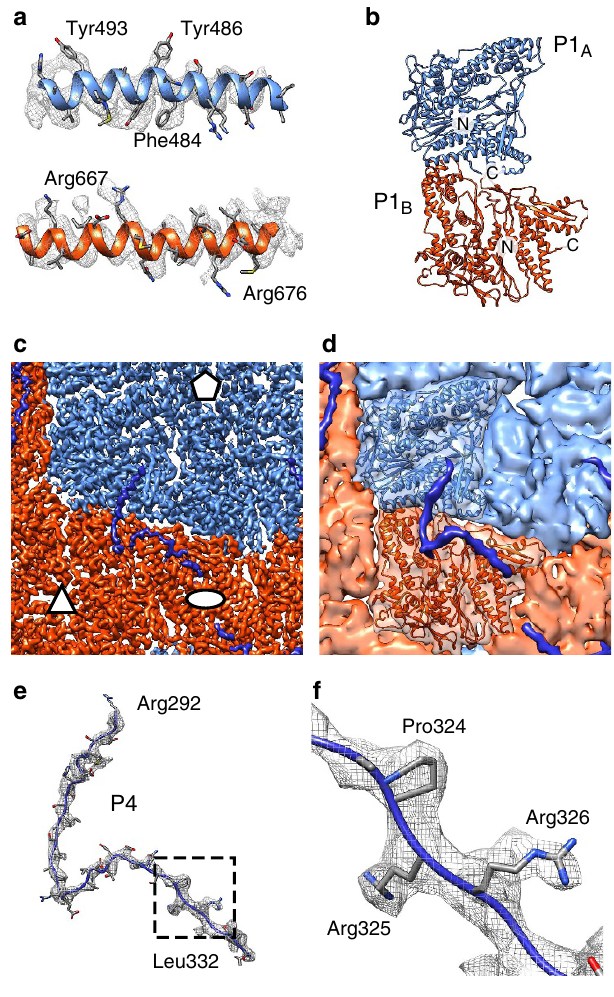
Figure 4 | Structure of the inner P1 shell. ( a ) Close-ups of the atomic models for the f 6 P1 A (top) and P1 B (bottom) subunits and corresponding density (mesh). ( b ) Atomic model of the asymmetric P1 dimer. The two subunits and the N- and C-termini are labelled. ( c ) Close-up of the density map. Icosahedral symmetry axes are labelled with an ellipse (two-fold), a triangle (three-fold) and a pentagon (five-fold). ( d ) Same view as in c but a rough molecular surface is shown for clarity and one P1 dimer is shown as a ribbon. P1 A is blue, P1 B is red, and density assigned to P4 C-terminal part is dark blue. ( e ) Atomic model for the P4 C-terminal part (R292–L332) and the corresponding density (mesh) are shown. ( f ) Close-up of the area indicated in e showing the 324-ProArgArg-326 motif that allowed assignment of this density to P4. See also Supplementary Fig. 4 and Supplementary Movie